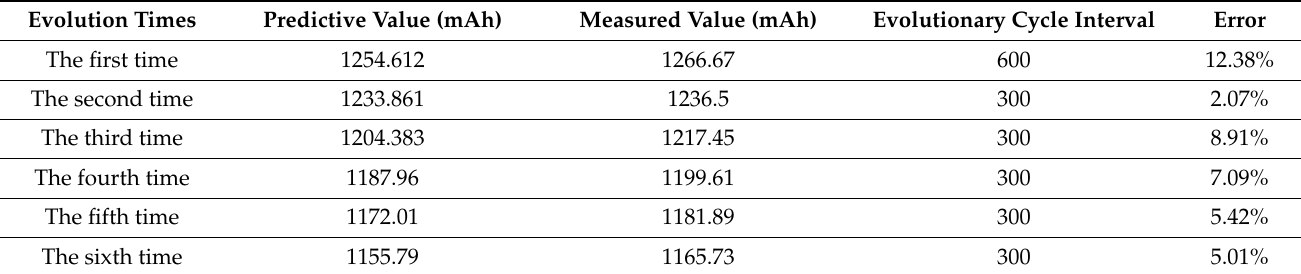
Table 8. The result of model evolution with adaptive